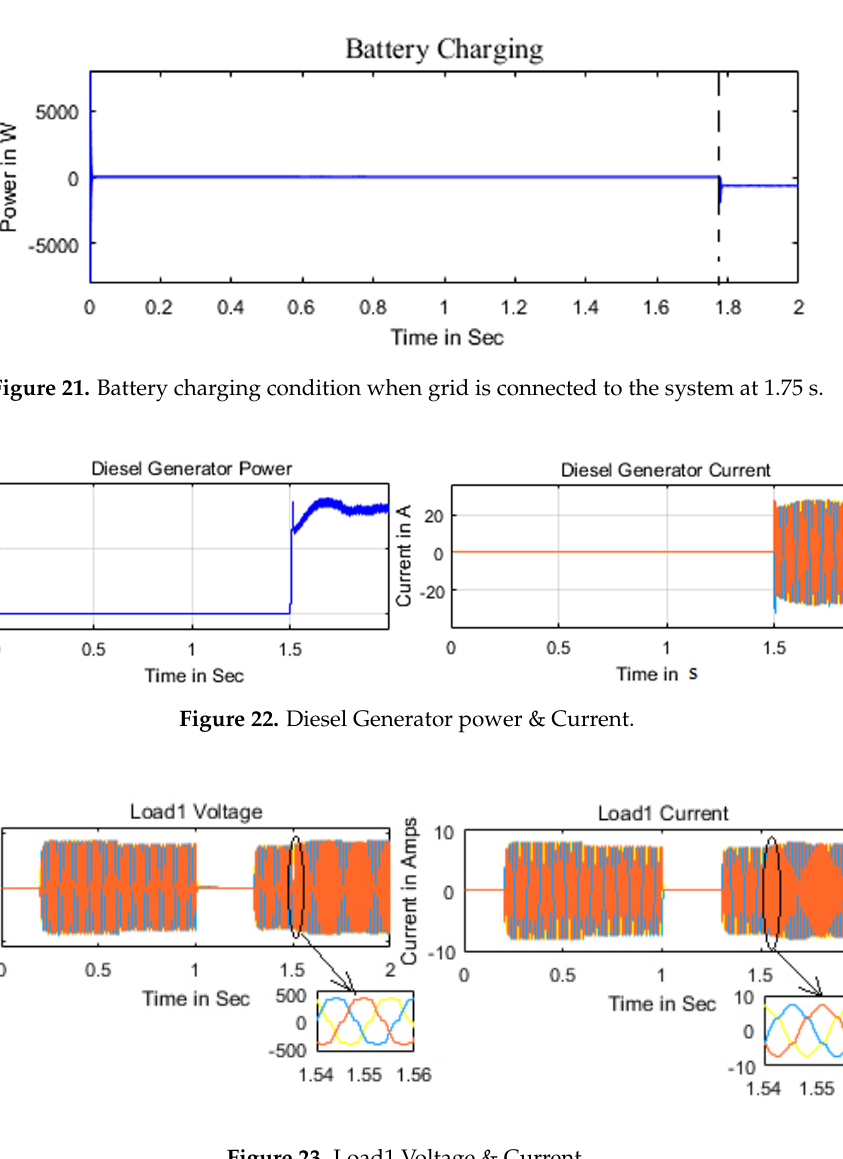
Figure 23. Load1 Voltage &